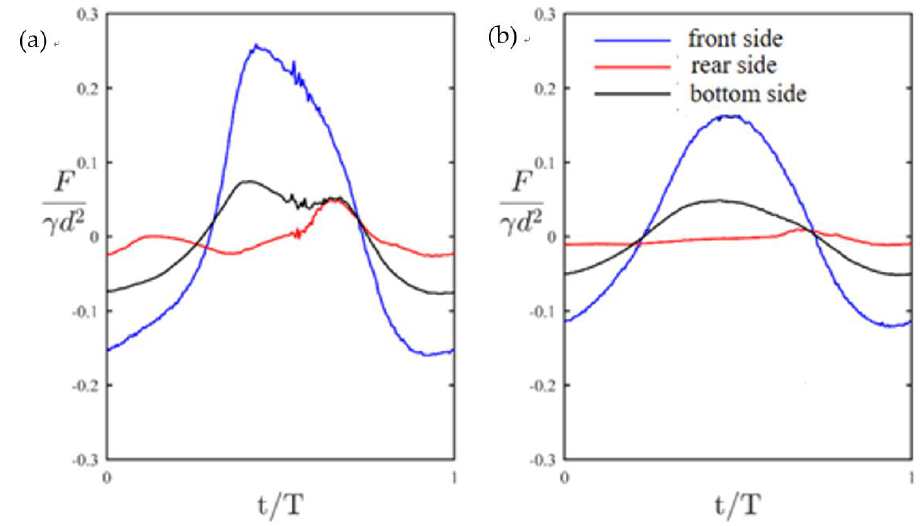
Figure 13. Enlarged view of maximum force in Figure 12: ( a ) H = 22.54 cm and T = 1.94 s and ( b ) H = 12.01 cm and T = 1.94 s.